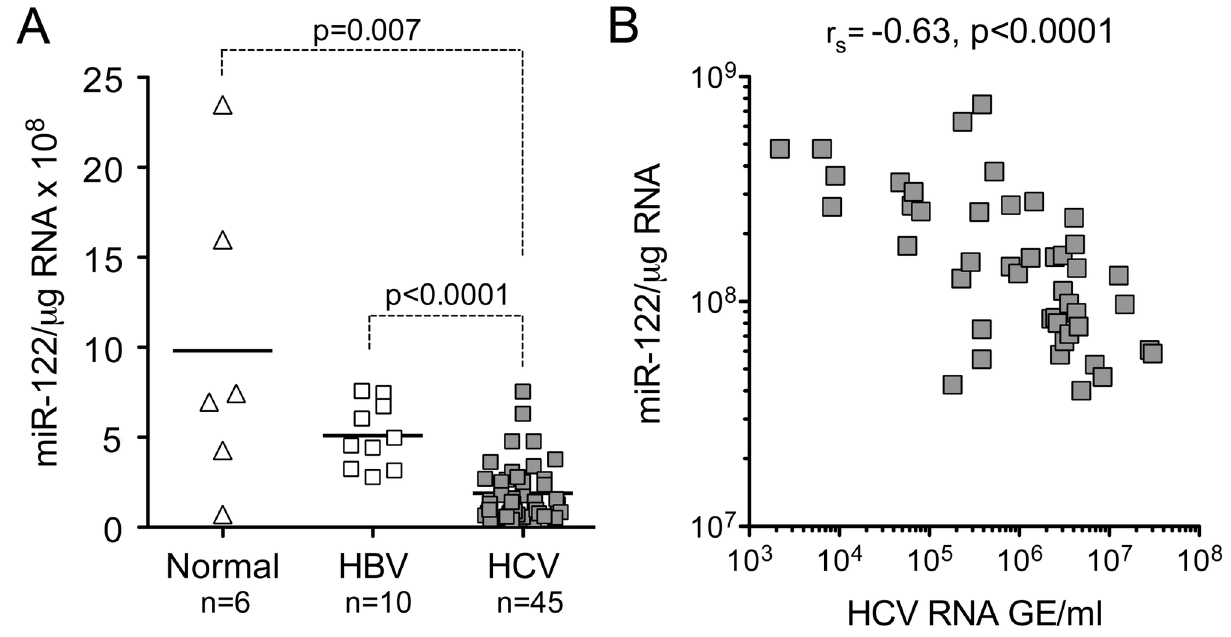
Figure 4. miR-122 expression in chimpanzee liver tissue. ( A ) Hepatic miR-122 abundance in liver biopsies from chimpanzees infected with HBV or HCV, or not infected with either virus (‘normal’). Statistical significance was assessed by non-paired two-sided t test. Bars represent mean values. ( B ) Liver miR-122 expression plotted against serum HCV RNA abundance from acutely HCV- infected chimpanzees. r = Spearman rank-order correlation coefficient. s doi: